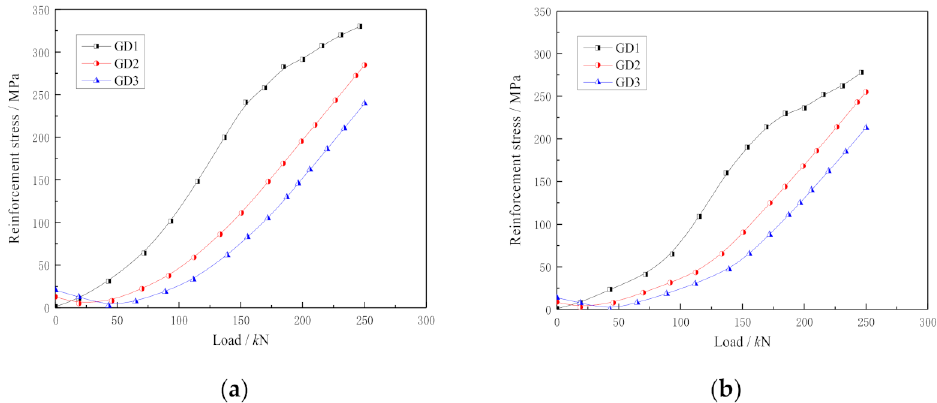
Figure 21. Stress-load curve of No. 1 steel bar: ( a ) B measuring point and ( b ) C measuring